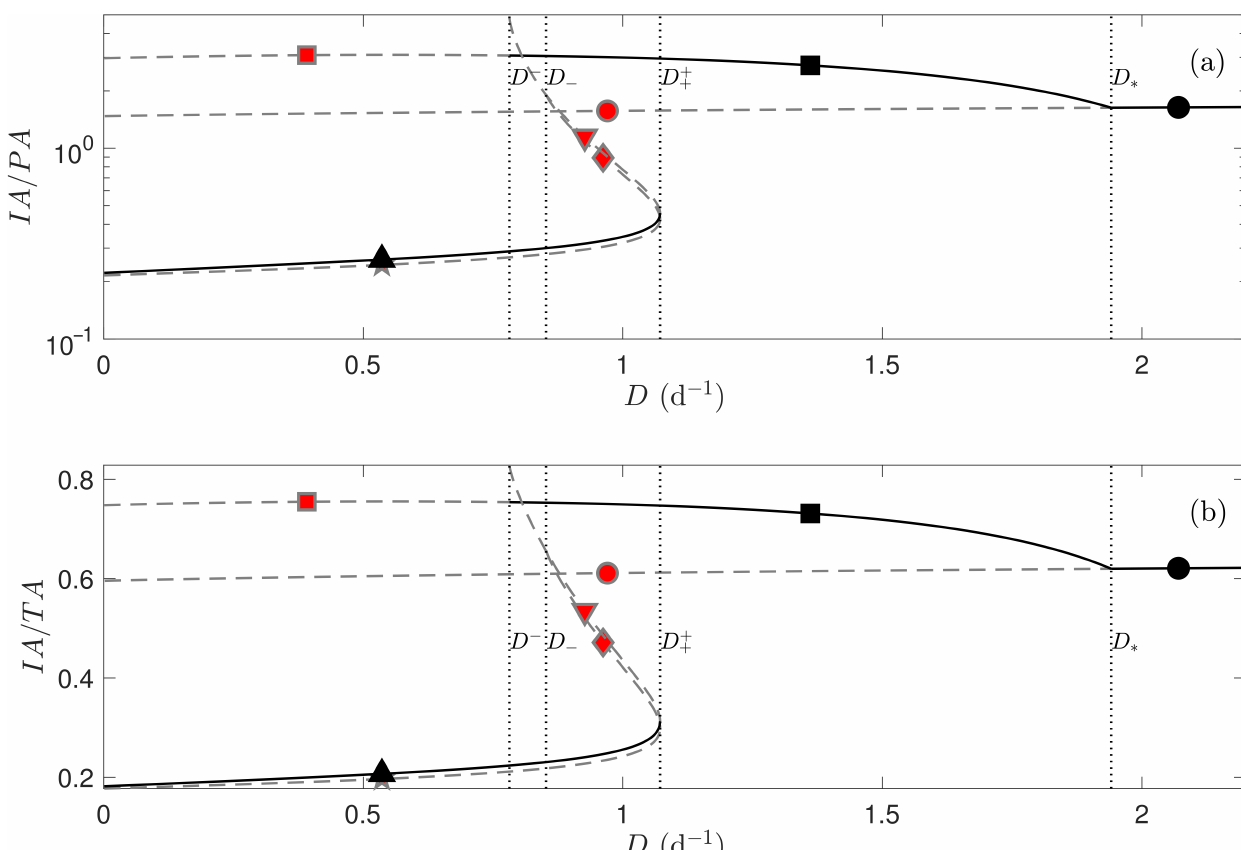
Figure 4. Bifurcation and stability analysis for ( a ) IA:AP ratio and ( b ) IA:AT ratio of the modified AM2 model with the parameters presented in Table 2. The continuous lines with black markers represent stable EP, the dashed lines with red markers represent unstable EP and the dotted lines are the bifurcation points, while the shape of the markers indicates the regions for each EP: (cid:4) = EP2, (cid:7) = EP3a, (cid:70) = EP3b, (cid:72) = EP4a, and (cid:78) =